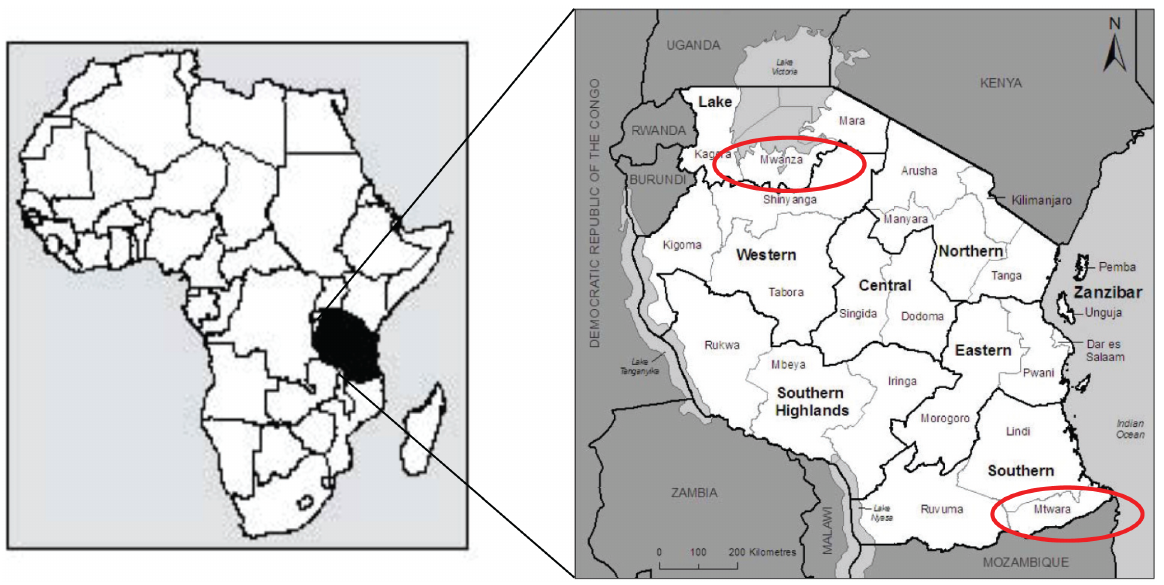
Figure 1. Map showing Mwanza and Mtwara Regions (Tanzania HMIS, 2008). Reference: Tanzania Comission for AIDS (2008). Tanzania HIV/ AIDS and Malaria Indicatory Survey 2007–08. Dar es Salaam, Tanzania.